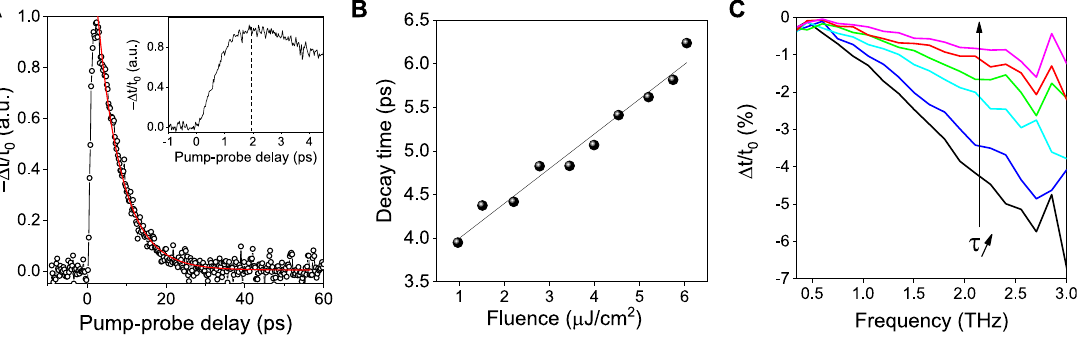
Figure5: (A)Thedynamics ofthechangeof thetransmission − Δ t / t 0 asafunctionofthepump – probedelaytime.(B)Decaytimeof − Δ t / t 0 as a functionoftheincidentopticalpump fl uence,showingaslow-downofthedecayastheincident fl uenceisincreased.(C)Frequency-dependent differential transmittance spectra Δ t ( ω )/ t 0 ( ω ) measured at different pump – probe delay times from 2 ps to 9